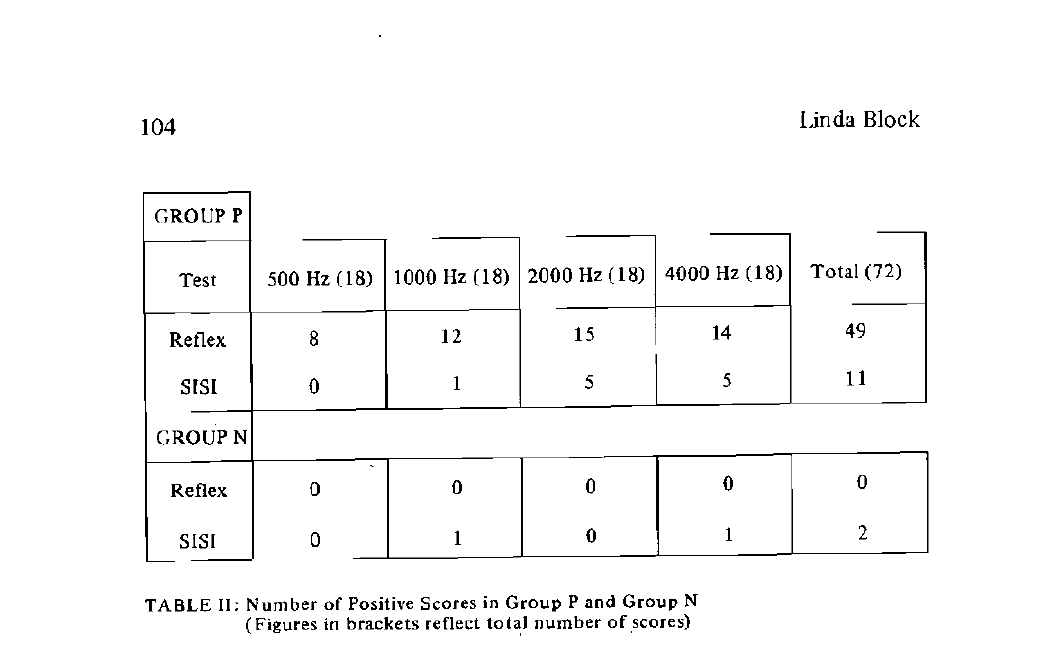
TABLE II: Number of Positive Scores in Group Ρ and Group Ν (Figures in brackets reflect total number of scores)